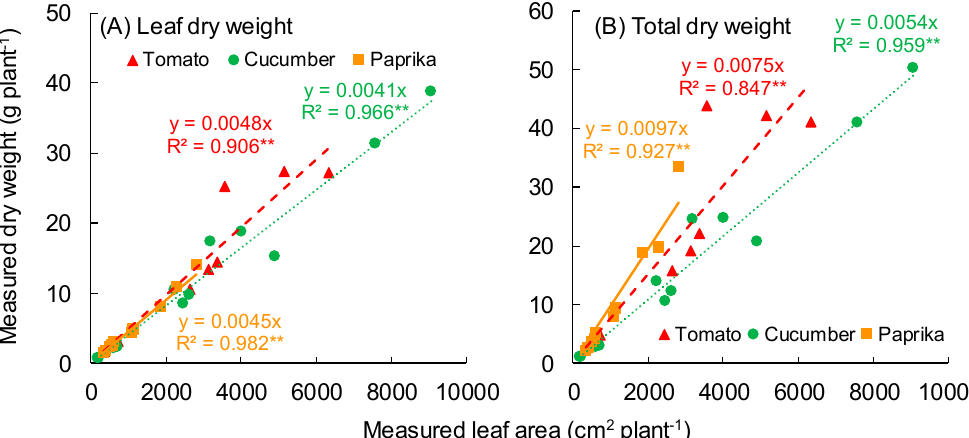
Figure 9. Relationship between measured leaf area and dry weight (leaf or total). ( A , B ) show the dry weights of leaf and total, respectively. The total dry weight does not include fruit. The leaf area was measured using an area meter (LI-3100, LI-COR Inc., Lincoln, NE, USA). Tomato plants were scanned using the 3D scanner (DPI-8X, Opt Technologies Co., Ltd., Tokyo, Japan) from 5 April to 23 May 2019. Cucumber plants were scanned from 3 April to 23 May 2019. Paprika plants were scanned from 5 April to 2 August 2019. ** significant at p < 0.01 according to the regression analysis.